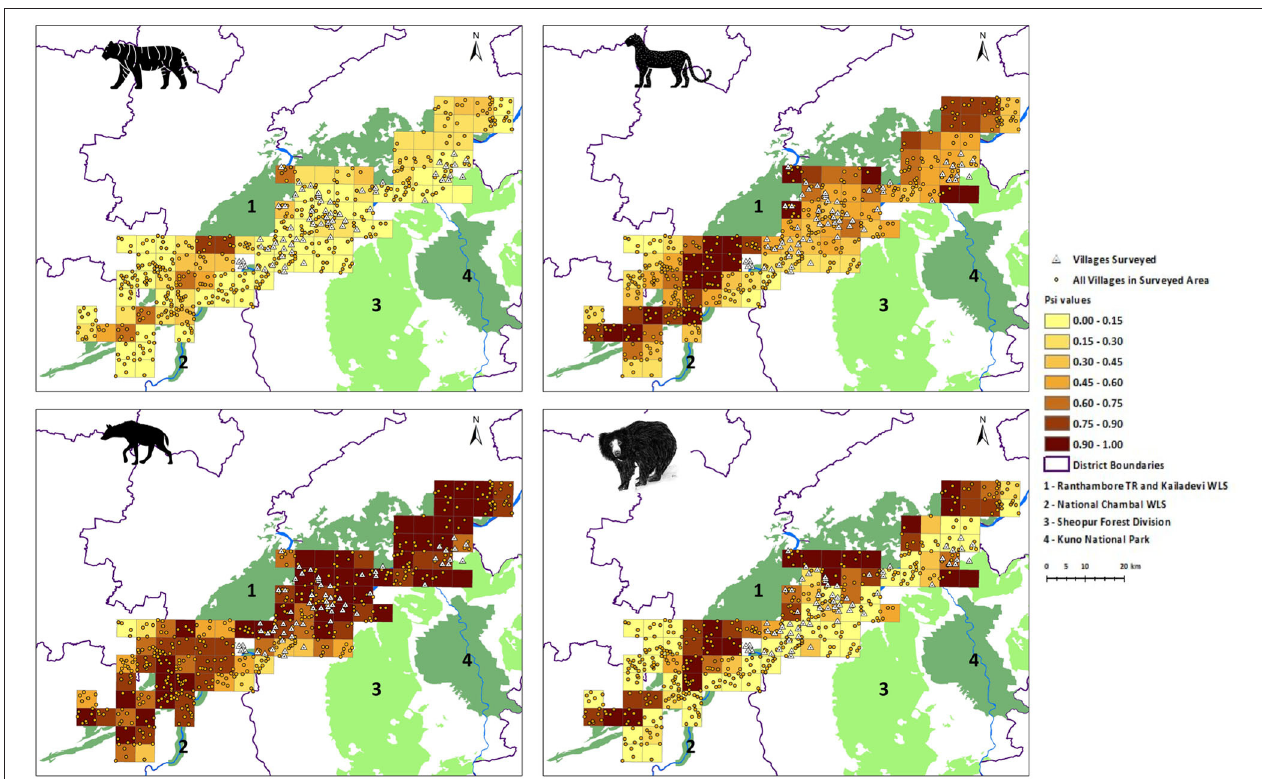
FIGURE 5 | Estimated probabilities of habitat-use/occupancy for all four focal species. Striped hyenas are widespread across the landscape, followed by leopards, sloth bears, and tigers. Leopards are largely concentrated around the forest edges and sparse across most of the landscape whereas sloth bears and tigers are restricted to the edges of the forest areas and are negligibly present across the